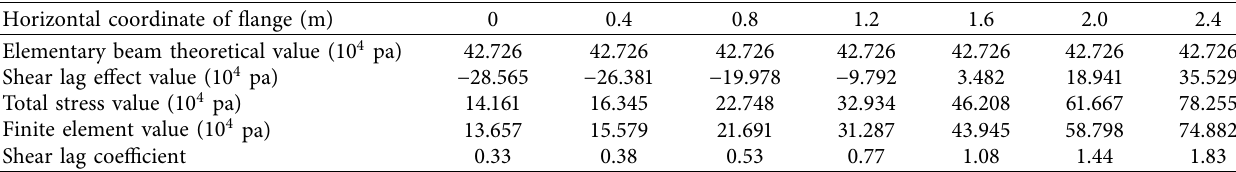
� L � 12 m) (uniform load). 1 2